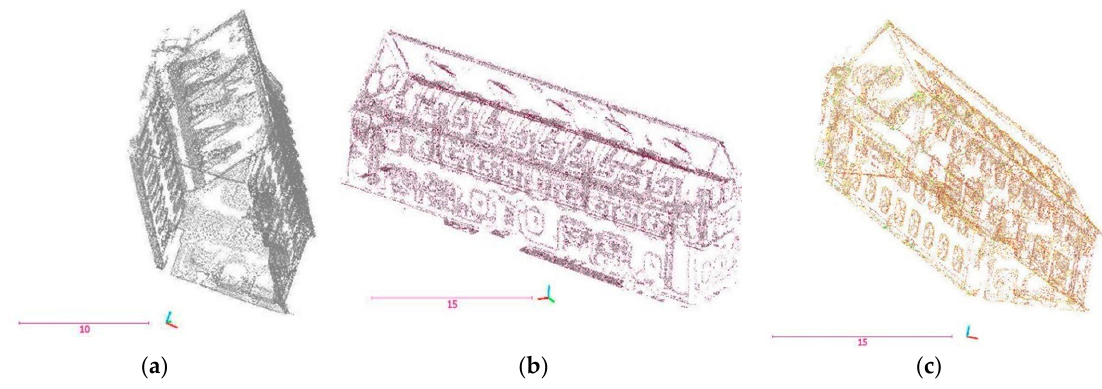
Figure 8. The remaining points using ( R 1 , R 2 ) of ( a ) (0.015, 0.2), ( b ) (0.15, 0.8) and ( c ) (0.1, 0.5). Units in figures are m.